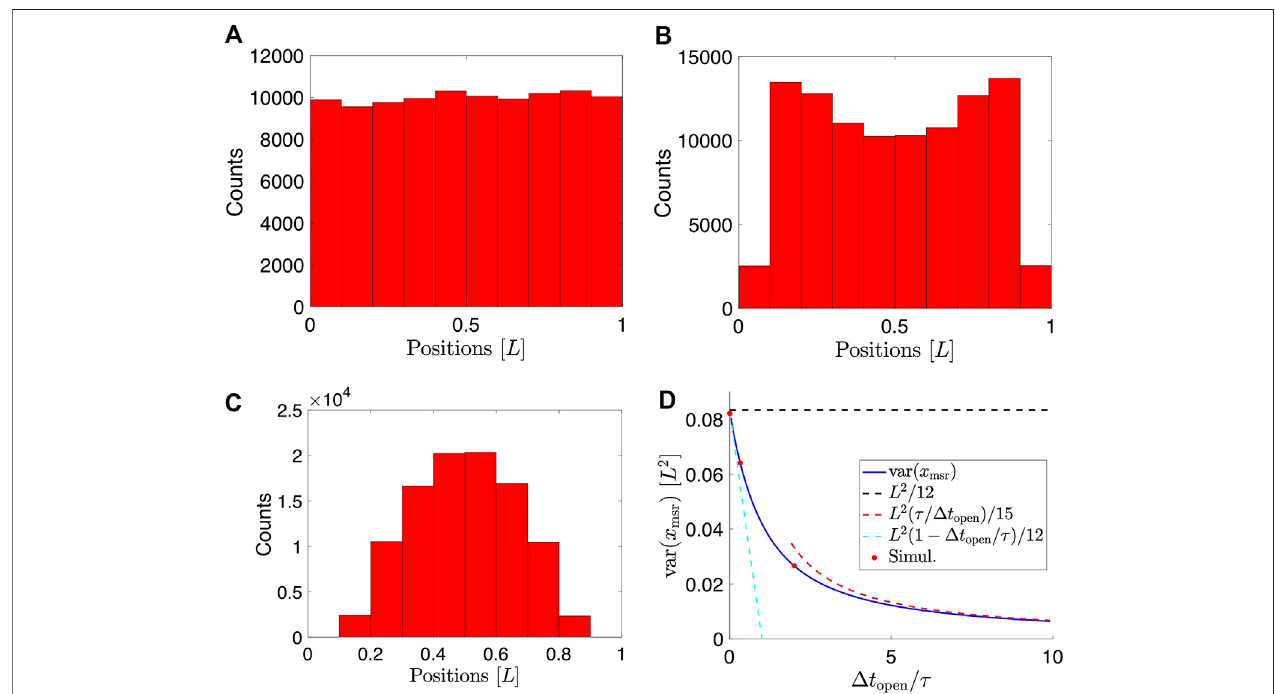
FIGURE2| Histograms ofmeasured positions for Δ t open / τ (cid:2) 0.01 (A) , 0.33 (B) , and 2 (C) forsimulatedBrownianmotion ofaparticleina1D box. (D) Thevariance of measured positions Δ t open / τ for the exact expression in Eq. 18 (blue full line), the approximate expression in Eq. 19 valid for Δ t open / τ ≫ 1 (red dashed line), and the approximate expression in Eq. 20 valid for Δ t open / τ ≪ 1 (cyan dashed line). Horizontal black dashed line: variance (cid:2) L 2 / 12, the value for Δ t open / τ → 0. Red dots: the sample variances of the simulated data in (A) – (C)